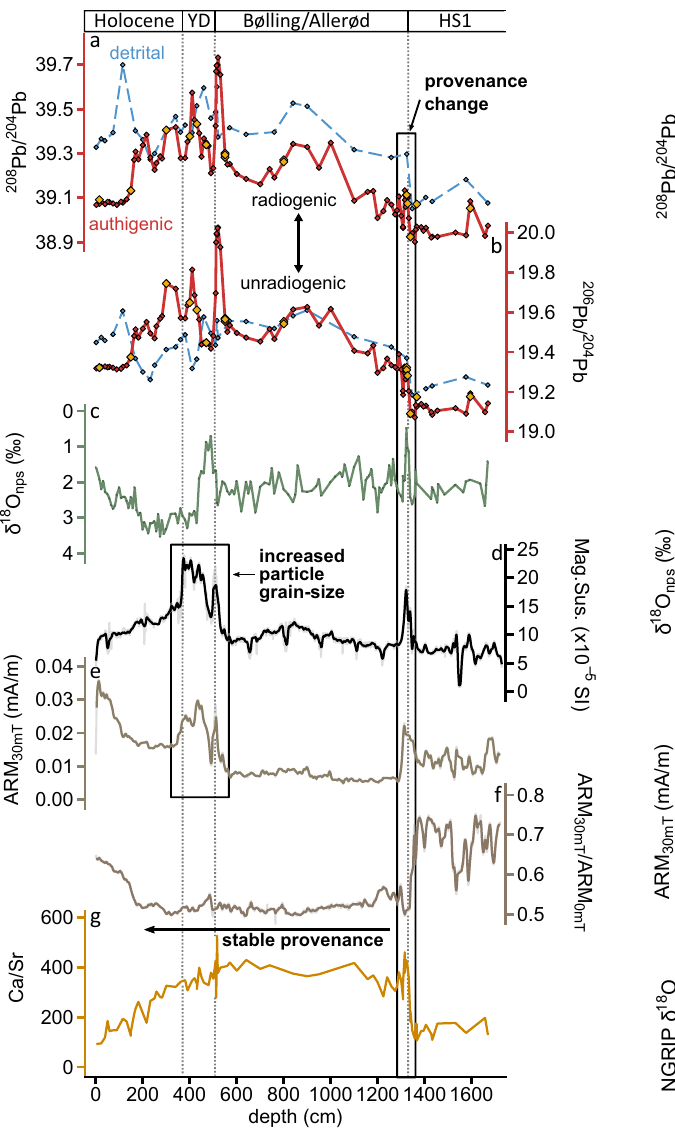
Fig. 3 Geochemical and bulk sediment properties of sediment core HLY1302 JPC-15/27. Data are shown against depth (cm) due to the large sedimentation rates >1 m/ka. Dashed lines mark the position of the climatic periods Bølling – Allerød and Younger Dryas. a and b Authigenic (red) as well as detrital (dashed blue) 208 Pb/ 204 Pb ( a ) and 206 Pb/ 204 Pb ( b ) signature. Orange diamonds display results of replicate analyses of the authigenic samples. c Stable oxygen isotope data ( δ 18 O) in ‰ of planktonic foraminifera N. pachyderma s . and d magnetic susceptibility 6 . e ARM 30mT record of JPC-15/27 complemented with f the ARM 30mT /ARM 0mT ratio of the same samples. g Ca/Sr ratio of the authigenic phase.